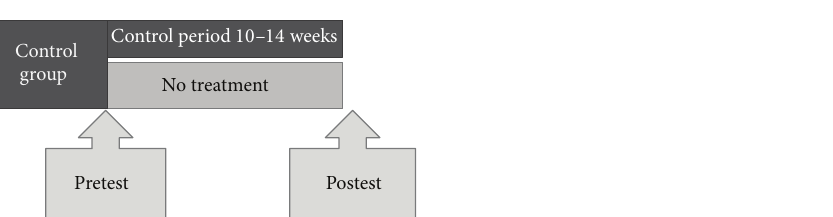
Figure 1: The schedule of the nonrandomised controlled clinical trial and the prospective follow-up study; participant recruitment, assessments, and stays during the lifestyle programme at NIMI Ringerike.